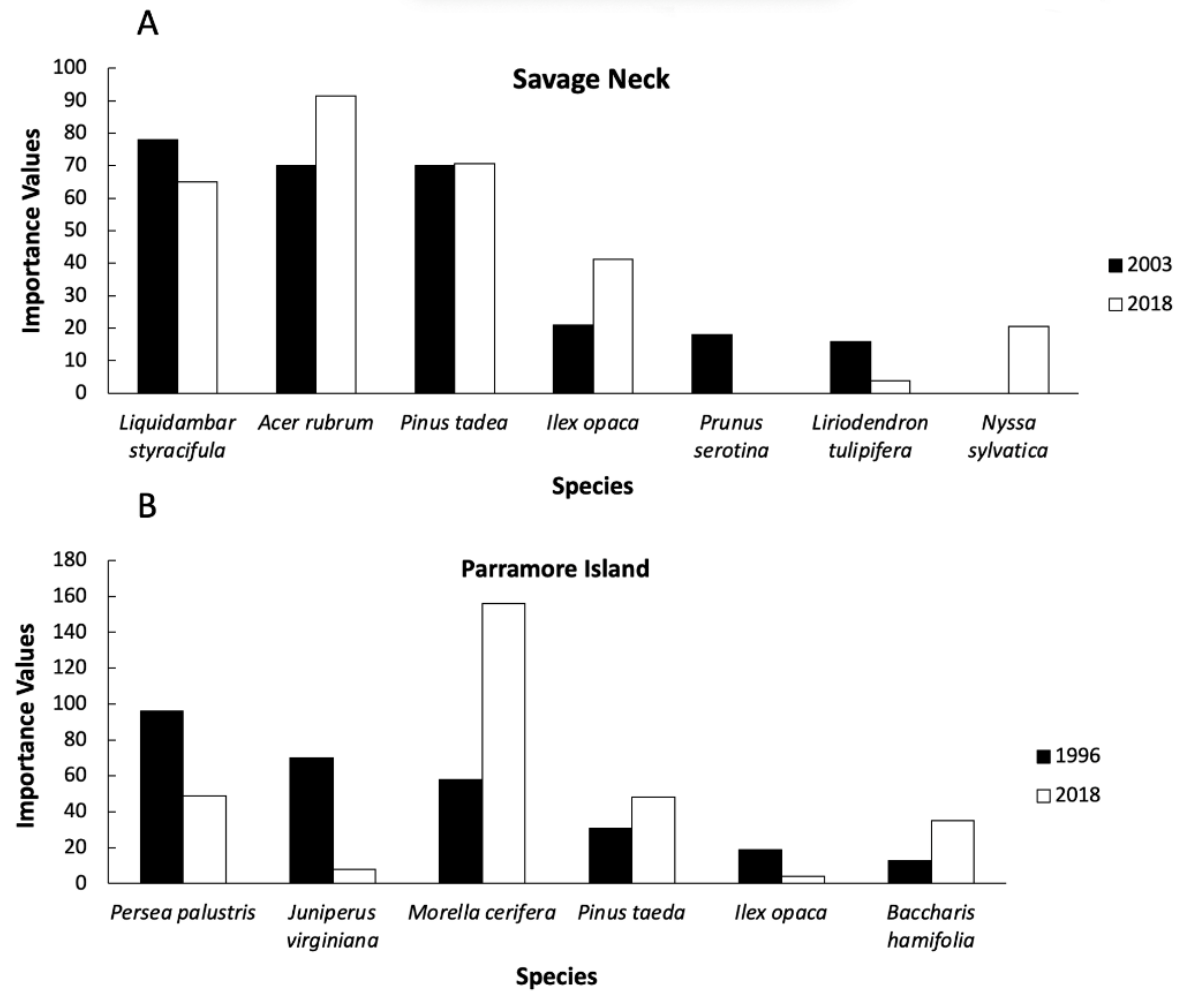
Figure 3. Importance values for Savage Neck ( A ) and Parramore Island ( B ). At Savage Neck, species have similar distribution from 2003 and 2018. On Parramore Island, there is a change in cover from tree to shrub dominance from 1997 to 2018. Only the top six species are shown in this graph for each site for each time period.